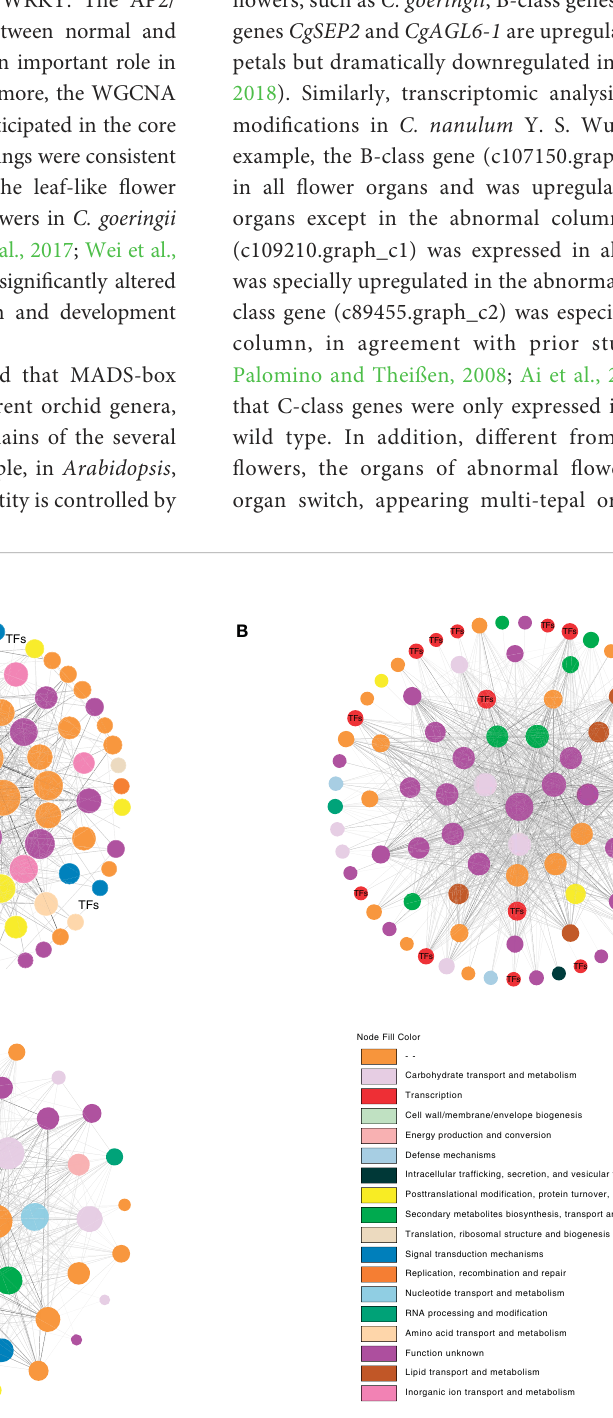
FIGURE 8 Co-expression network analysis of the cyan, pale turquoise, and dark turquoise modules. The depth of the node fi ll size represents the degree. The depth of the edge color represents the weight. (A) cyan module. (B) pale turquoise module. (C) dark turquoise